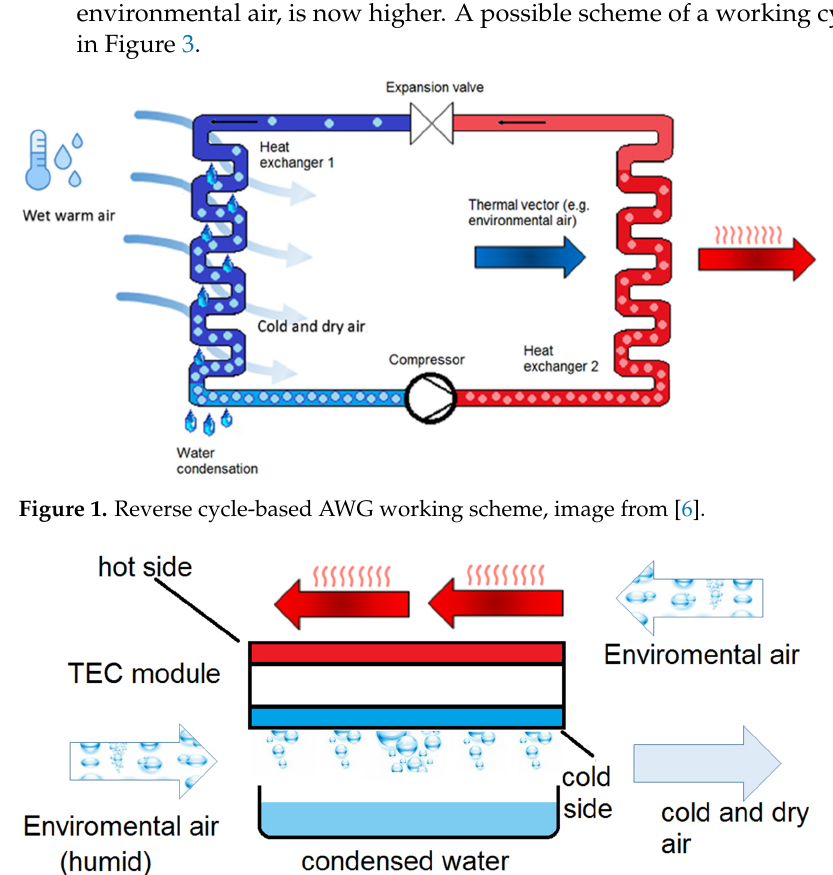
Figure 3. Desiccant-based AWG scheme, image adapted from [22]. The process permits the extraction of water while consuming less cooling energy, but the complete balance, including the heating energy, is not favourable in comparison with the reverse cycle technique. Nevertheless, if free cooling and/or free heating can be em- ployed, and/or natural temperature differentials can be used, the process can be effective [21]. Moreover, the technique can be interesting in cold zones where environmental air presents a dew temperature equal to or less than 4 °C, providing an alternative method to extract water that avoids defrosting cycles for the coils. Up until today, the desiccant- based approach has been used when a few litres per day of production is needed because it requires large spaces to usefully embed the desiccants [21]. It is worth noting that a new approach has been proposed lately. It can be called a “hybrid solution” because it couples the desiccant technique and the reverse cycle. For example, in [23], desiccants coat the condenser coils, and the heat released by the refrigerant is used to regenerate them. In [24] desiccants were gathered into a rotating wheel placed at the air inlet section of the reverse cycle after its passage on the condenser. In such a way, the air gathered humidity from the desiccant and was then cooled by the evaporator. Desiccants are charged by environ- mental air. The process of humidity harvesting and releasing is carried out continuously. This approach, which needs more study cases and real applications, is promising as it could reduce the energy required to produce water compared with the above-mentioned AWG technologies [24].